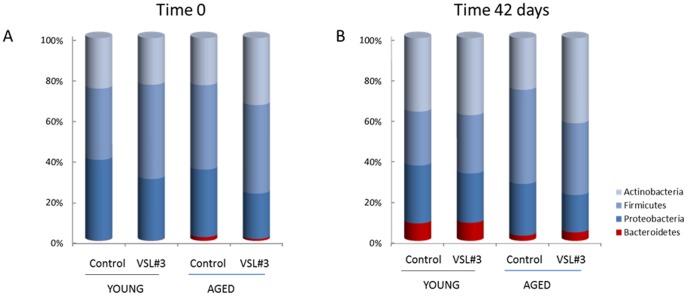
Phylogenetic profiles of gut microbiote in young and aged rats treated with a control diet or VSL#3.(A-B). Terminal restriction fragments (T-RFs) of microbial communities from feces of young control rats (YC), young rats administered VSL#3 (YV), aged control rats (AC) and aged rats administered VSL#3 (AV) from day 0 (panel A) and 42 (panel B)were assigned to hierarchical taxonomic groups using the on-line software MiCA. Values of taxonomic ranks are expressed in percentage as a proportion of the reference library used for analysis (H.Q. database).